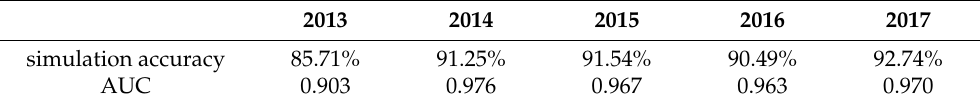
Figure 12. ROC curves of the neural network risk simulation model of H7N9 outbreaks in China from 2013 to 2017. Table 3. Simulation results of the neural network risk simulation model of H7N9 outbreaks in China.